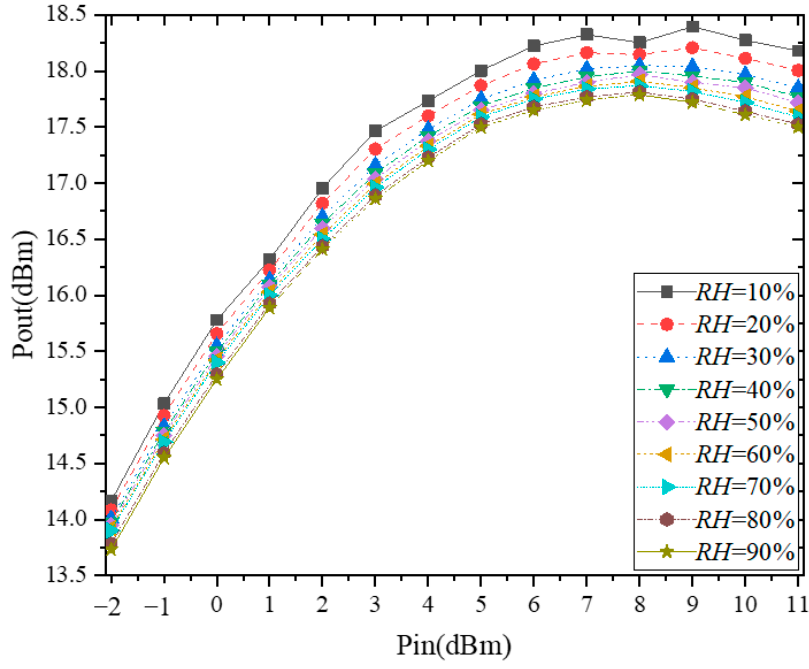
Figure 6. Measured output power vs. humidity at 433 MHz.